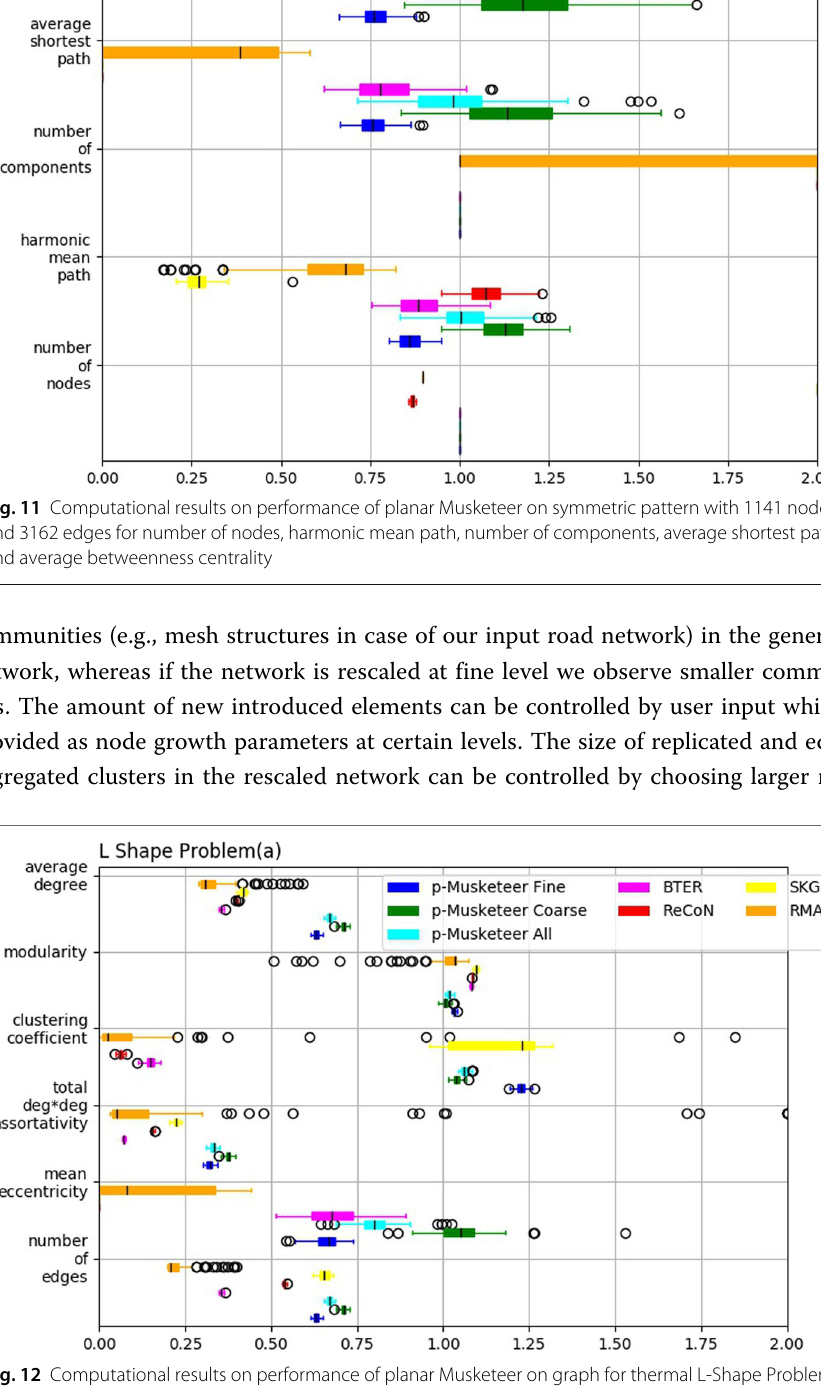
Fig. 12 Computational results on performance of planar Musketeer on graph for thermal L-Shape Problem with 3025 nodes and 8904 edges for clustering coefficient, number of edges, mean eccentricity, total degree *degree assortativity, modularity and average